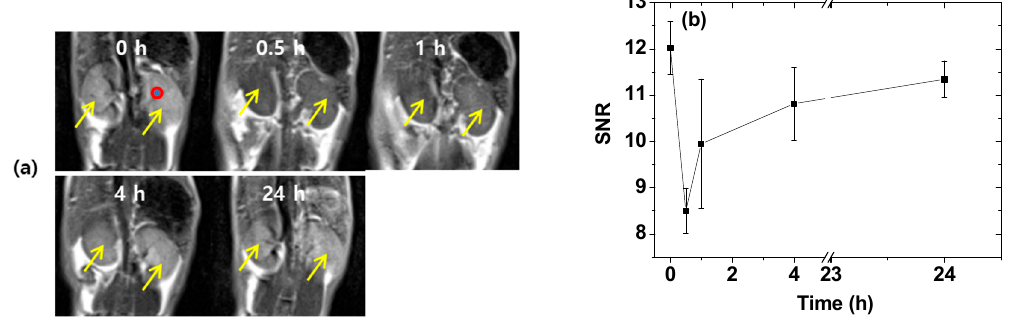
Figure 8. In vivo MRI results of the aqueous DYO@C nanoparticle solution sample. ( a ) In vivo coronal T 2 MR images of the mice kidneys (indicated with arrows) as a function of time (a small circle indicated a region-of-interest (ROI) used for the signal-to-noise ratio (SNR) plot) and ( b ) SNR plot of ROI as a function of time. Here, 0 h indicates preadministration, and the remaining time points indicate follow-up as a function of time after administration of the aqueous solution sample into mice tail veins. Four mice were used.